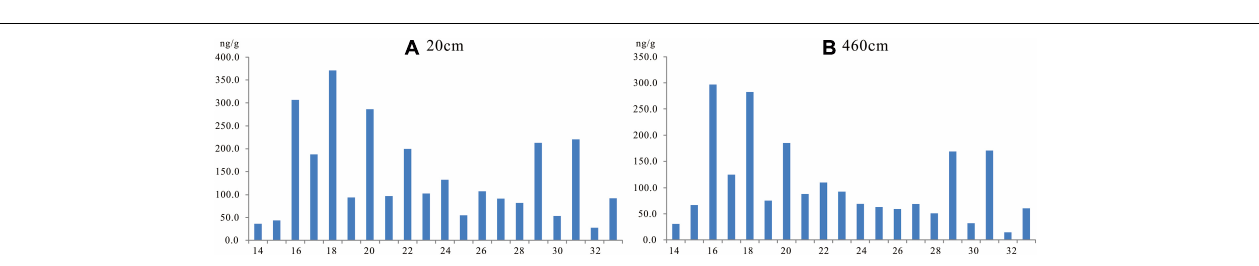
nitrogen in the core sediment B are also mostly marine sources, which is consistent with the result of the